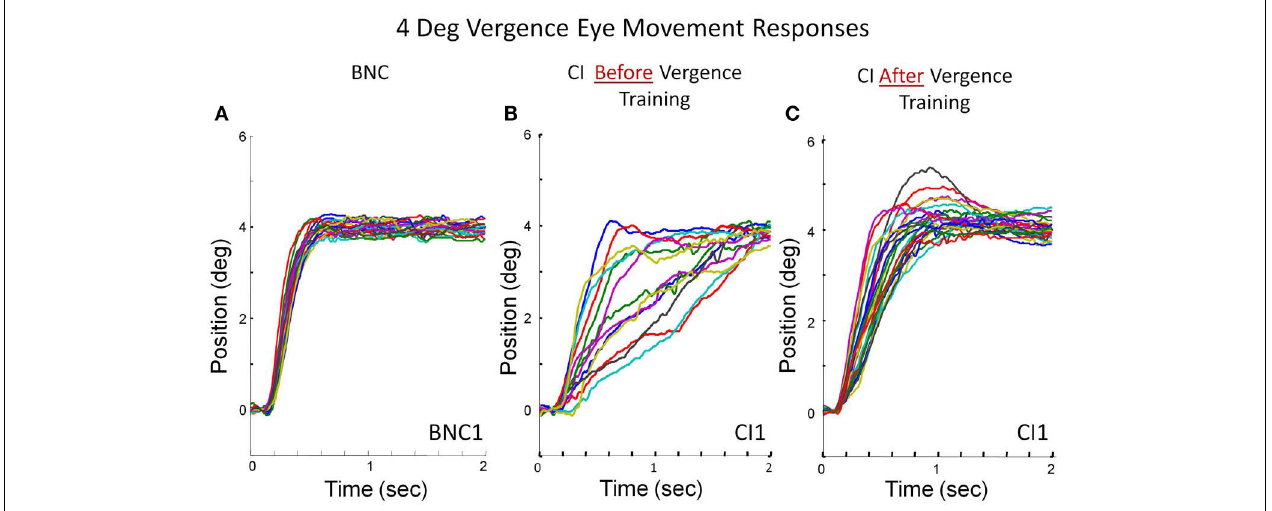
after 18h of vergence training (C). Each colored trace is a single eye movement response denoted in degrees of rotation as a function of time (s).